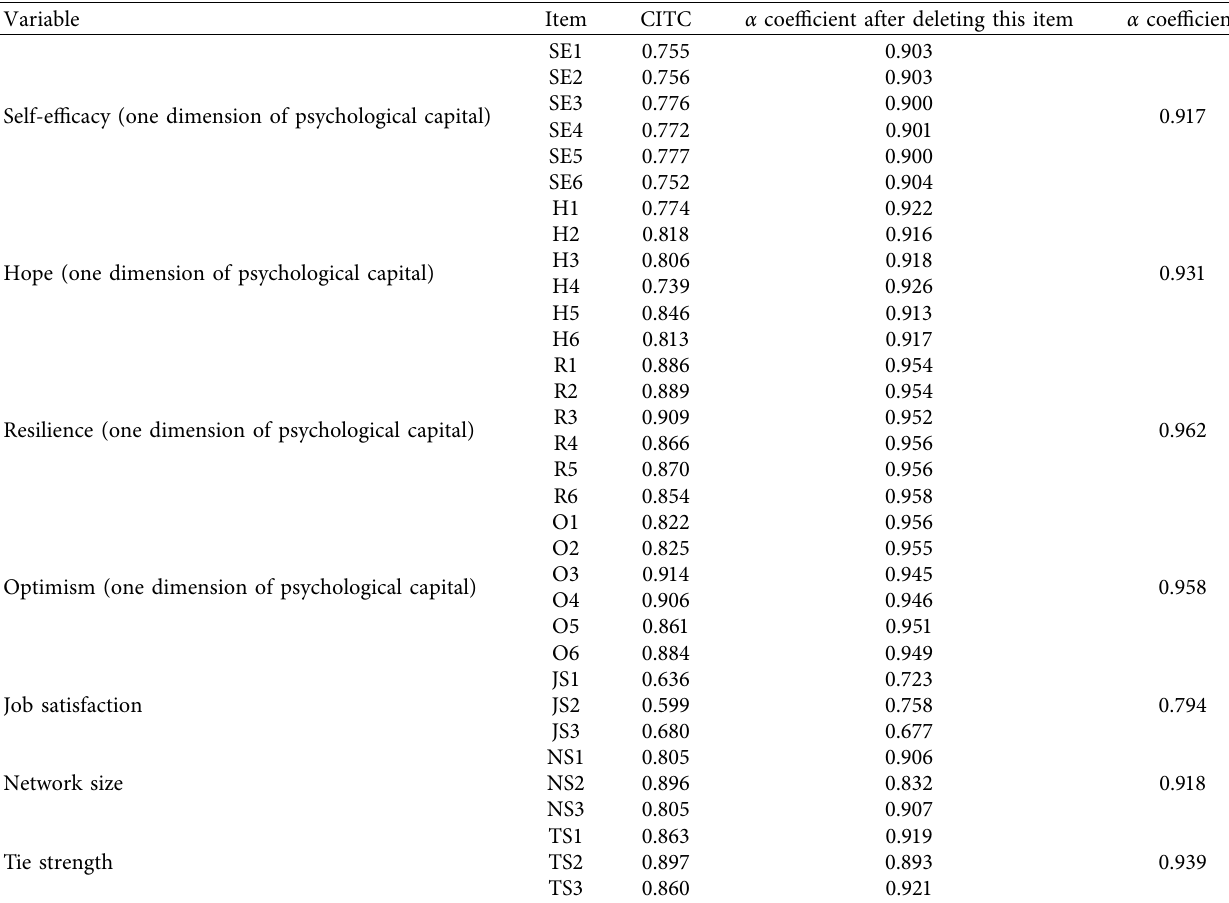
Table 3: The reliability of each item in the survey.